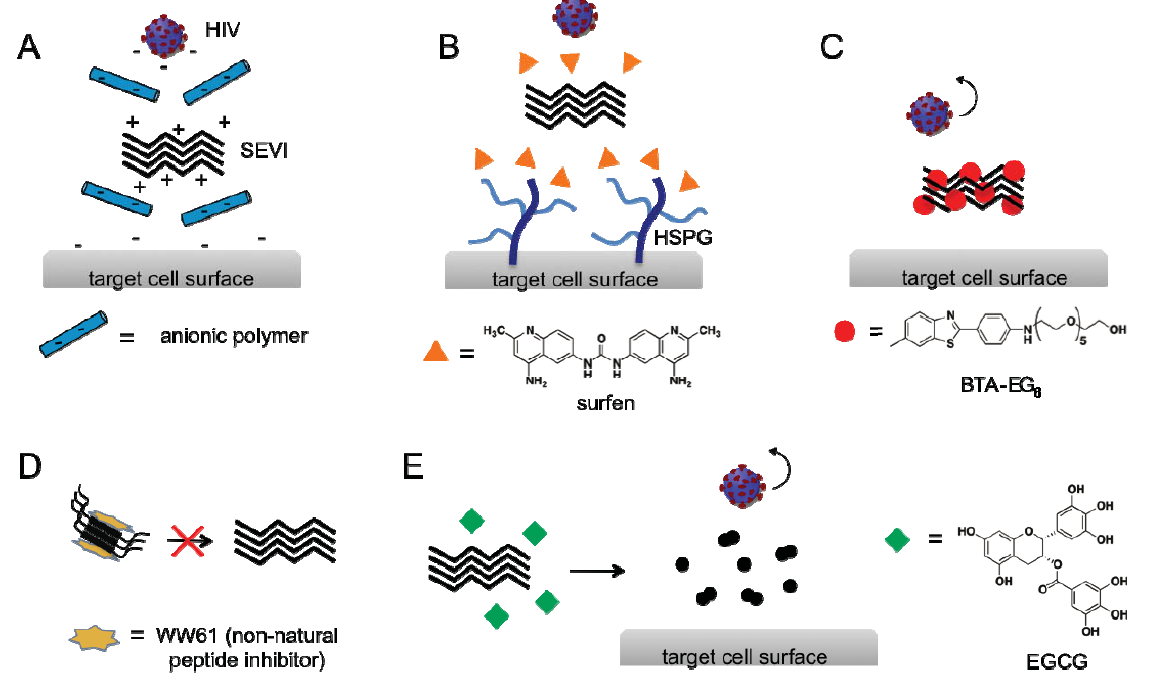
Figure 3. Mechanisms of action of anti-SEVI agents. ( A ) Anionic polymers shield the intrinsic positive charges of SEVI and inhibit the binding of SEVI to HIV virions; ( B ) Surfen, a heparin sulfate proteoglycan (HSPG) antagonist, inhibits interactions between SEVI and both HIV virions and target cells; ( C ) BTA-EG is a small molecule that engages 6 SEVI’s cross-(cid:2) structure by intercalating between (cid:2)-strands; ( D ) WW61, a non-natural peptide inhibitor (Trp-His-Lys-chAla-Trp-hydroxyTic), inhibits SEVI fibrillization by binding to and obstructing growing fibril ends; ( E ) Epigallocatechin-3-gallate